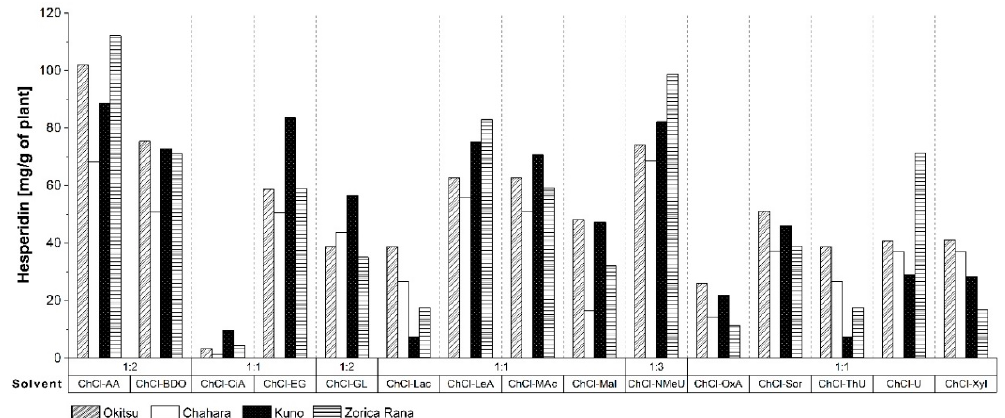
Figure 2. Comparative study of obtained hesperidin yields using di ff erent combinations of deep-eutectic solvents (DESs) comprising choline chloride (ChCl) and acetamide (AA), butane-1,4-diol (BDO), citric acid (CiA), ethylene glycol (EG), glycerol (GL), lactic acid (Lac), levulinic acid (LeA), malonic acid (Mac), malic acid (Mal), N-methyl urea (NmeU), oxalic acid (OxA), sorbitol (Sor), thiourea (ThU), urea (U), and xylitol (Xyl).